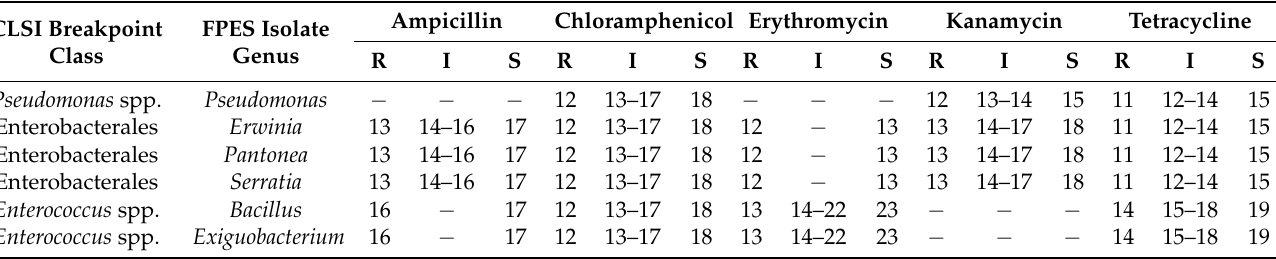
Table A1. Zone of inhibition breakpoints (mm) from the US Clinical and Laboratory Standards Institute M100, 30th ed. based on the genus of FPES isolates against Ampicillin, Chloramphenicol, Erythromycin, Kanamycin, and Tetracycline with R = resistant, I = intermediate, and S =